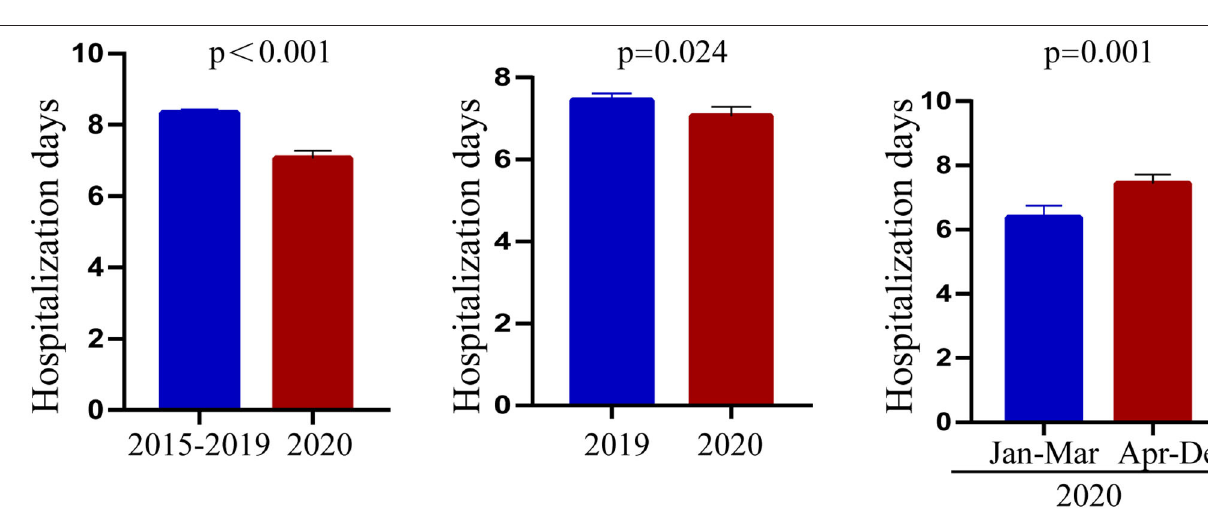
FIGURE 2 | Characteristics of hospitalization days before and after the COVID-19